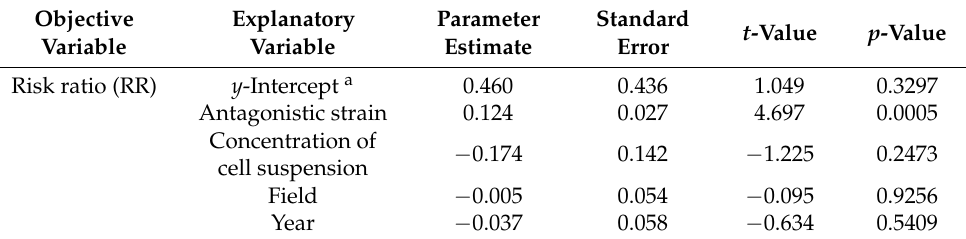
Table 1. Parameter estimates for the best-fit linear mixed model (LMM) for the factors related with the risk ratio (RR) of the biological control effect for grapevine crown gall (GCG) in 16 field trials over 12